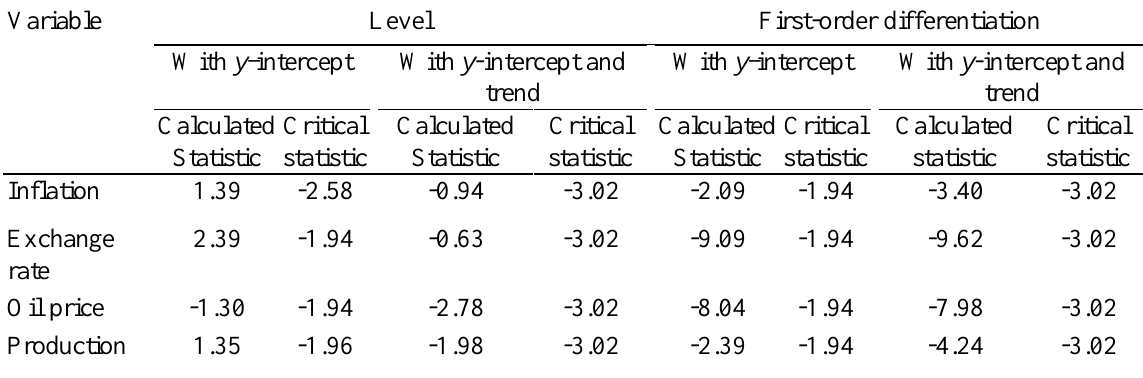
Table 1 . Results of augmented Dickey-Fuller unit root test for the variables included in the model